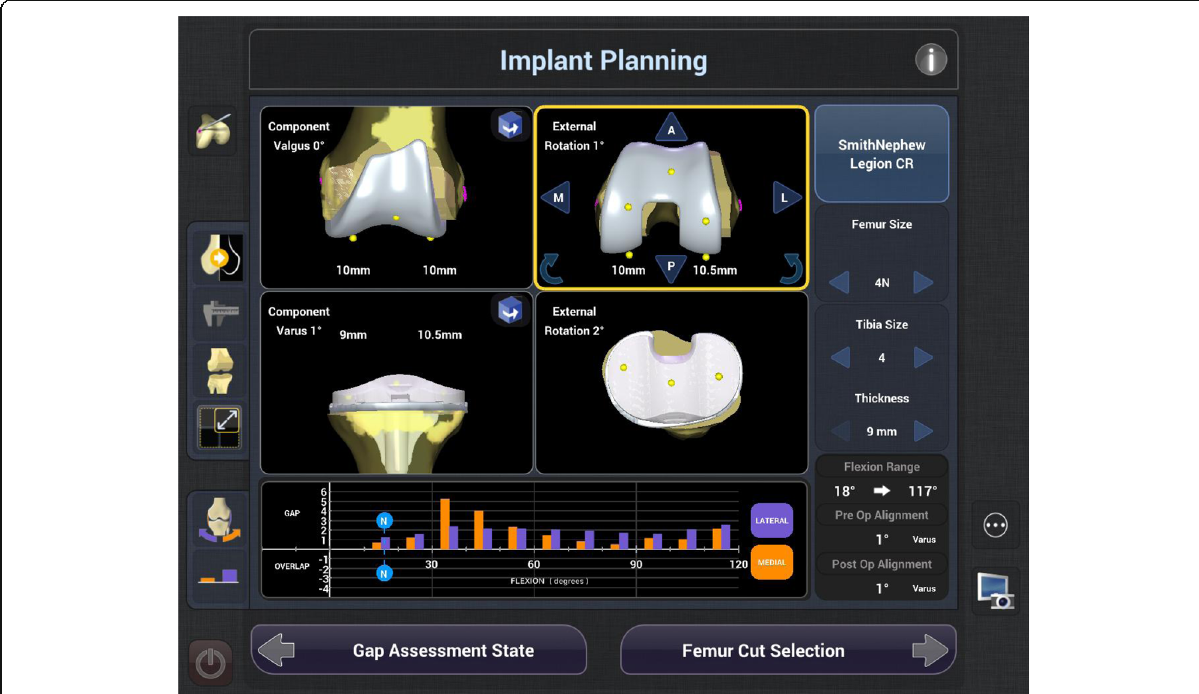
Fig. 5 Screen shot from the NAVIO (Smith and Nephew) console of robotically-assisted TKA demonstrating planned bone resection (purple). Robotic-systems allow implant position and sizing to be ‘ virtually ’ trialled giving the surgeon feedback on the effect on gap balancing, notching, prosthesis overhang